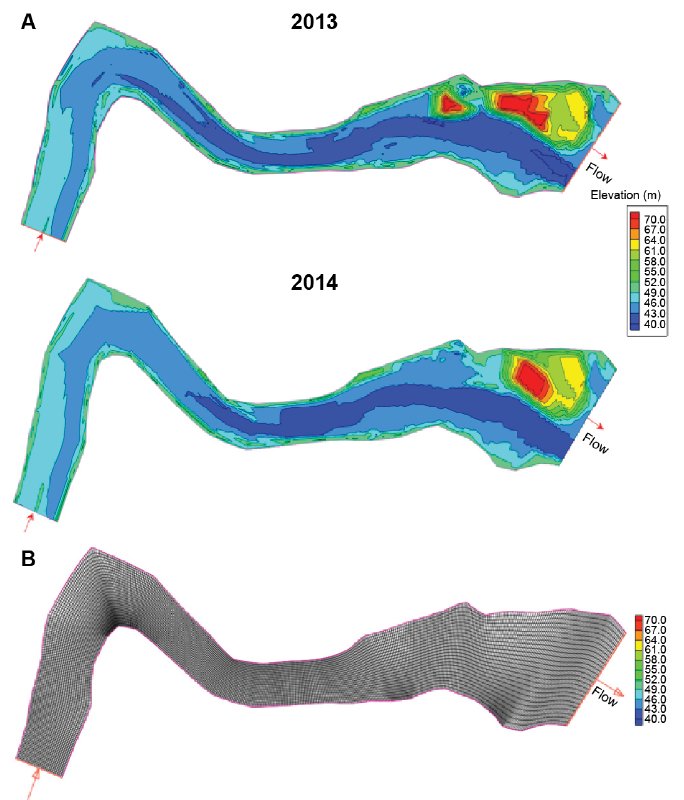
Figure 7. Topographic and elevation map of the study area: ( A ) distributions of bed elevation, ( B ) mesh of the study area.